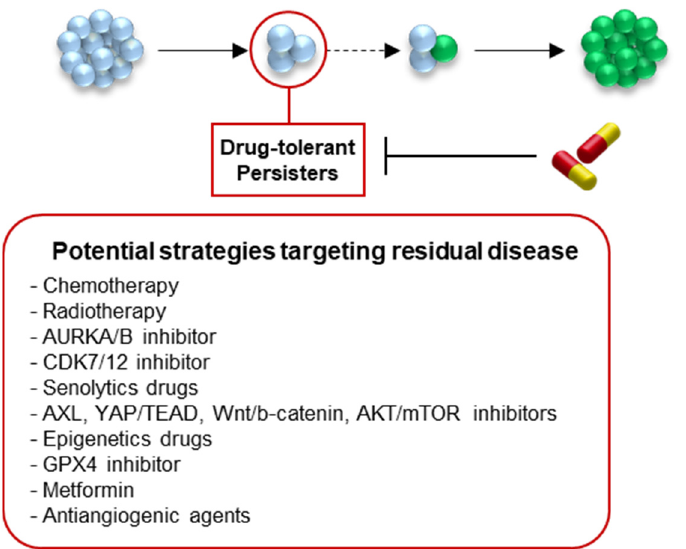
Figure 5. Therapeutic perspectives to improve targeted therapies outcome un lung cancer. Potential strategies to prevent the relapse include the maintenance and stabilisation of the DTP stage, the eradication of the DTP population after their establishment by targeting their key regulators, or the impediment to DTP generation. Several clinically relevant strategies are being tested.